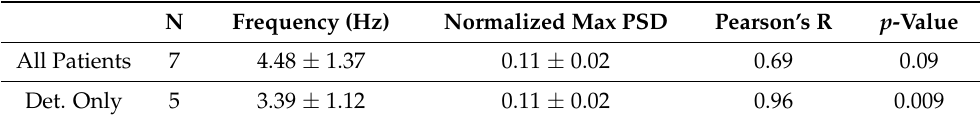
Table 2. “Sinusoidal Patients” experiencing deterioration experienced a significant increase in the frequency of their motion as the power in their motion increased. Det. = deterioration. N Frequency (Hz) Normalized Max PSD Pearson’s R p -Value All Patients 7 4.48 ± 1.37 0.11 ± 0.02 0.69 0.09 Det.